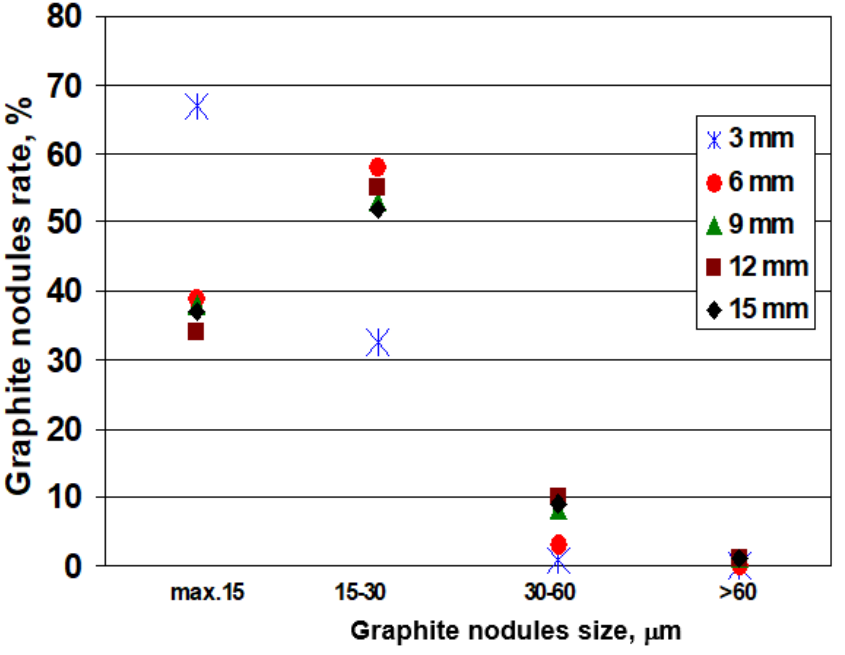
Figure 7. Influence of wedge casting wall thickness on the graphite nodules size rate distribution.